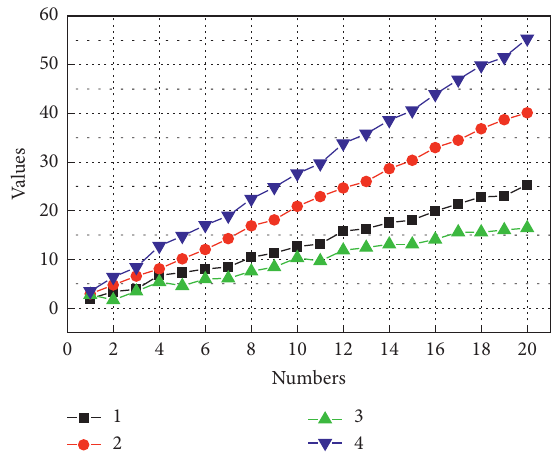
Figure 4: Invisible results of environmental and social